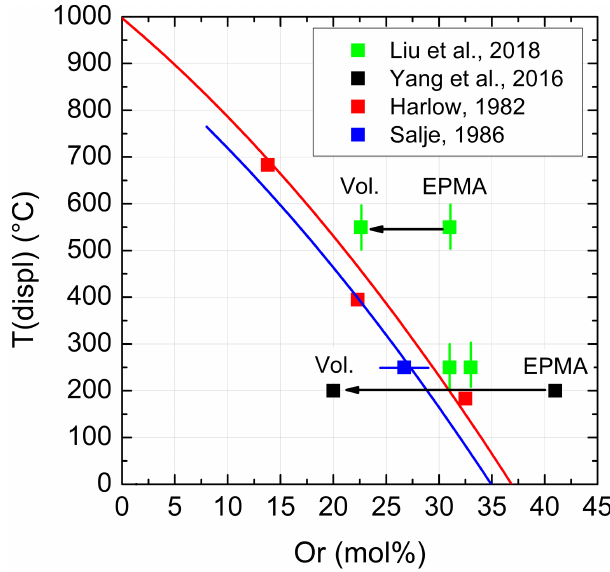
Figure 1. Variation with Or content of the temperature of the dis- placive phase transition in a few anorthoclases. The figure corre- sponds to Fig. 9a of Liu et al. (2018) but now contains the cor- rect transition temperatures of Harlow (1982). Indicated errors were taken from the literature. Two curves have been added that relate to samples with topochemically monoclinic Al,Si distributions equi- librated at 1050 ◦ C (upper curve) and 800 ◦ C (lower curve) (Kroll et al., 1980, Fig. 8; also see Zhang et al., 1996, Fig. 14). EPMA and Vol. denote Or contents determined from electron microprobe analysis and unit cell volume,